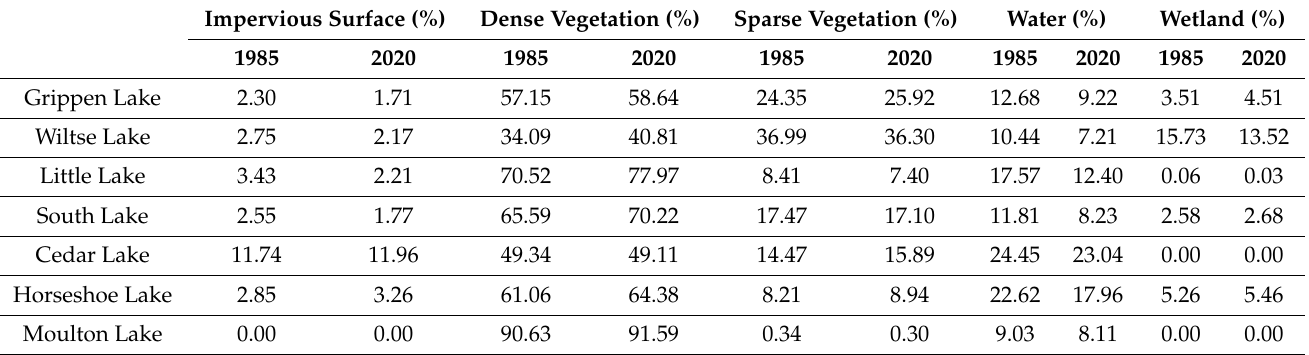
Figure 5. Land cover classification maps of nine lakes in 2020 : ( A ) Cedar Lake; ( B ) Grippen Lake; ( C ) Elodia Lake; ( D ) Horseshoe Lake; ( E ) Moutlon Lake; ( F ) Lamb Lake; ( G ) Little Lake; ( H ) South Lake; ( I ) Wistle Lake. Table 2. Summary of Land Cover Percentage (%) in 1985 and 2020.